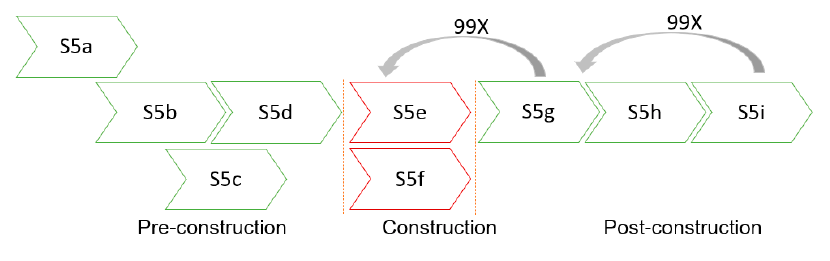
Figure 6. The process map for Scenario 4.